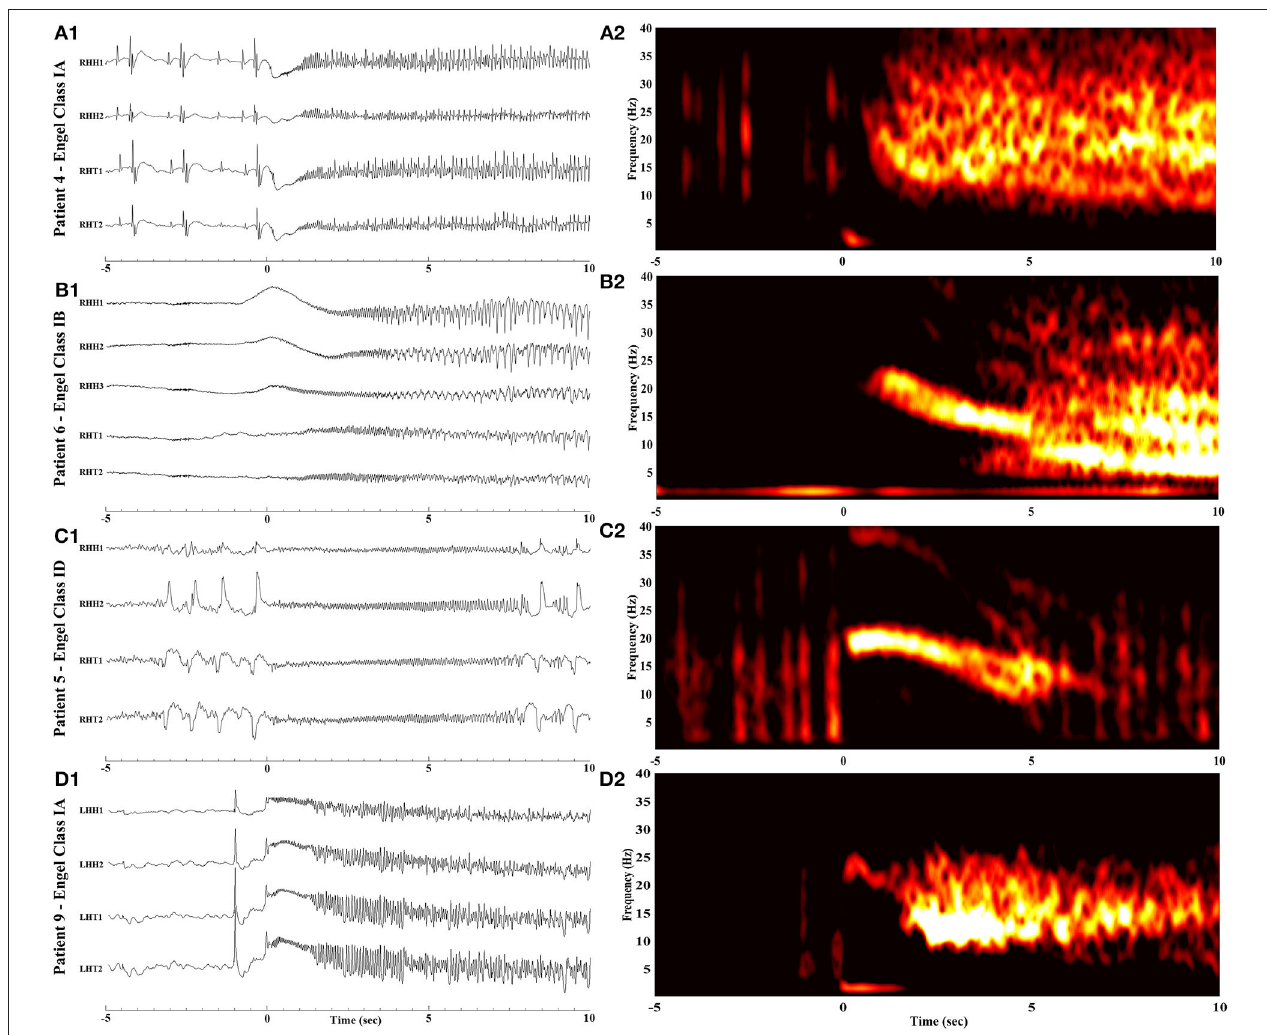
FIGURE 2 | Raw iEEG (left, A 1 -D 1 ) from the MT contacts and respective time-frequency analysis (right, A 2 -D 2 ) of seizure onsets in patients with favorable outcome. (A 1 ,A 2 ) Patient 4 with Engel Class IA outcome. (B 1 ,B 2 ) Patient 6 with Engel Class IB outcome. (C 1 ,C 2 ) Patient 5 with Engel Class ID outcome. (D 1 ,D 2 ) Patient 9 with Engel Class IA outcome. Notice that for all four patients, ictal frequency progressively declines following ictal onset (time =